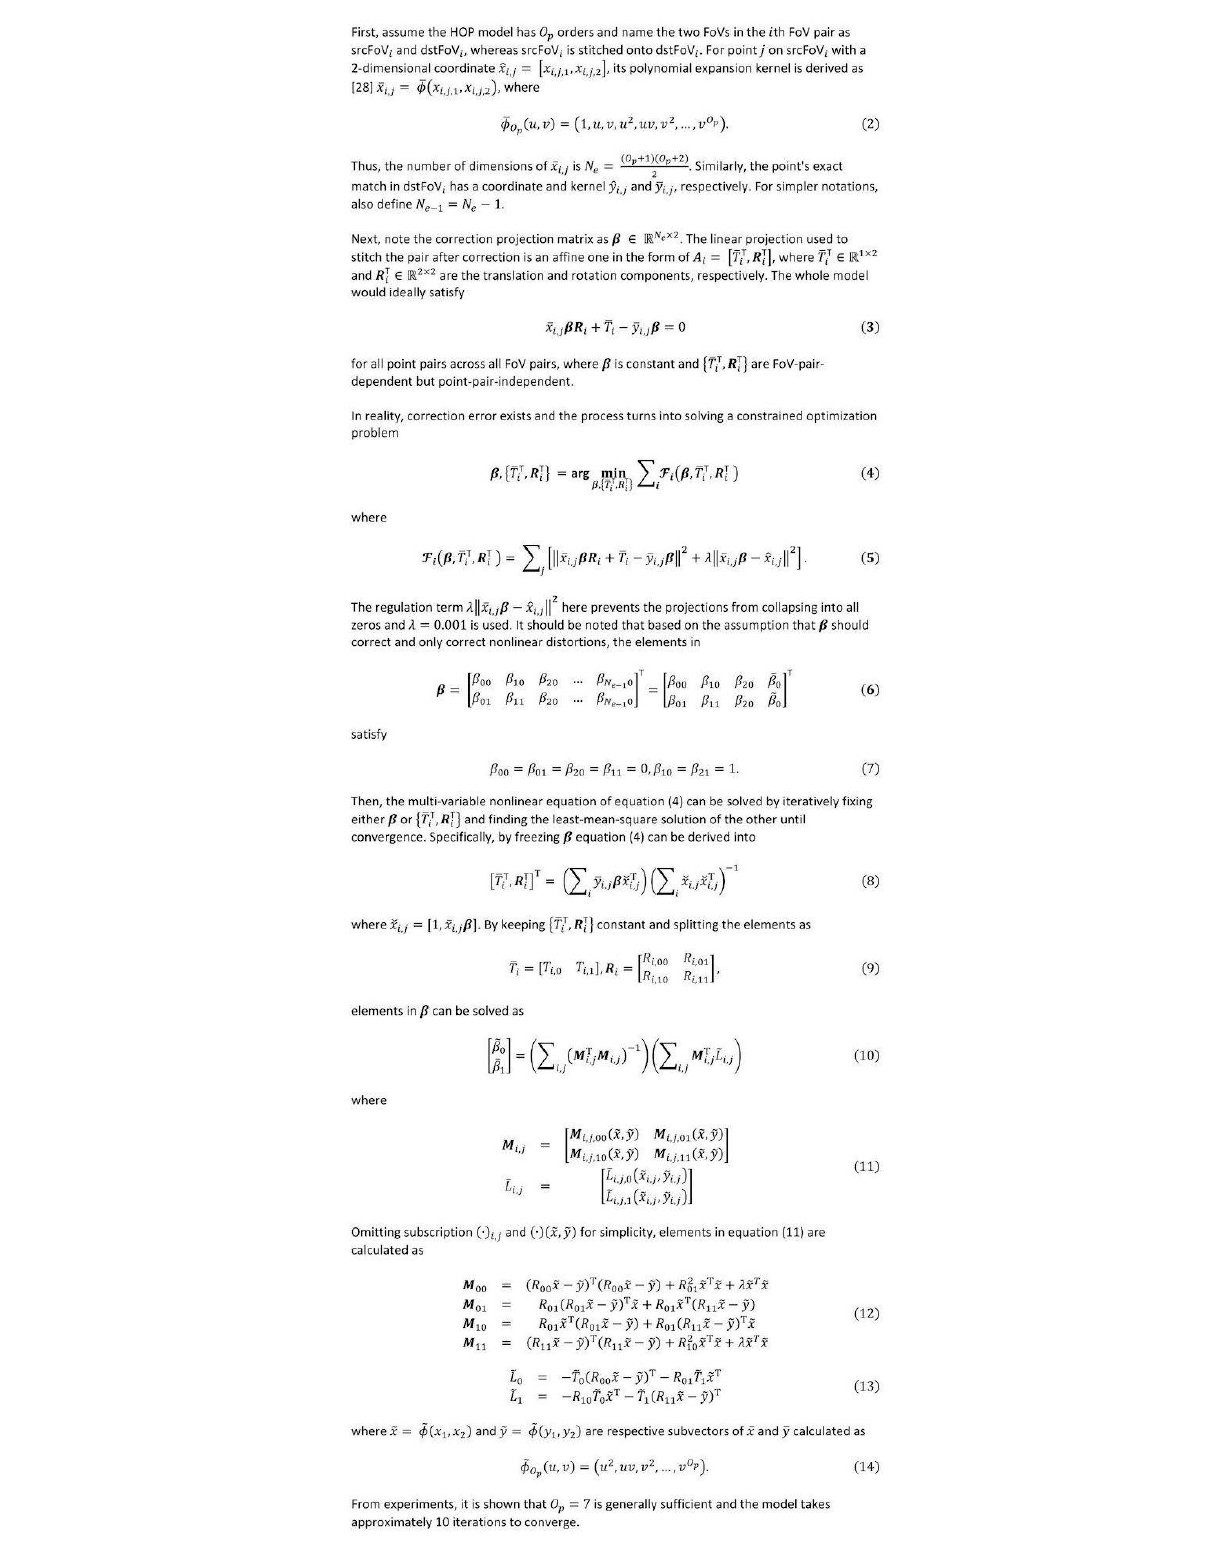
Figure 6. On-the-fly distortion correction based on matched